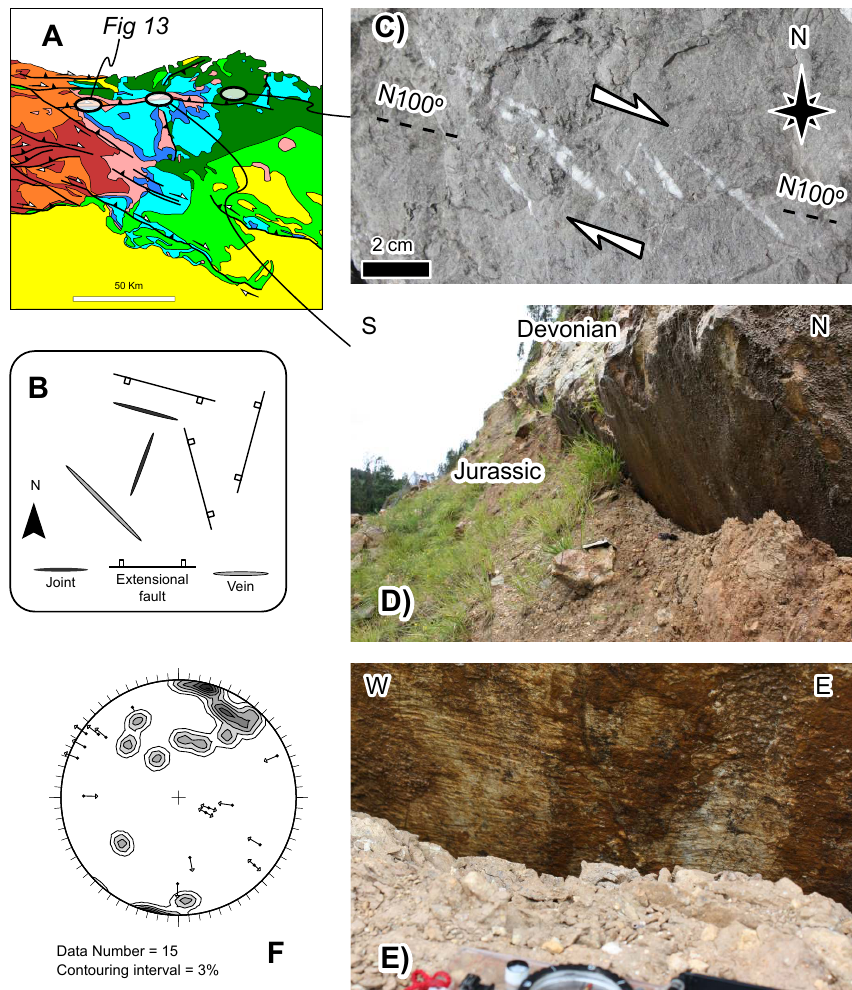
Fig. 13. (A) Geological map of the Cabu´erniga Fault area. (B) Schematic map view of mesostructural patterns recognised in the area by Tavani and Mu˜noz (2012). (C) Details of NW-SE striking en echelon veins, consistent with an E-W oriented right-lateral motion. (D) Photo of the tectonic contact between Devonian rocks and Jurassic marls along the central portion of the Cabu´erniga Fault, with detail of right-lateral slickenlines (E) and stereoplot of mesofaults in the northern damage zone of the fault (F) .